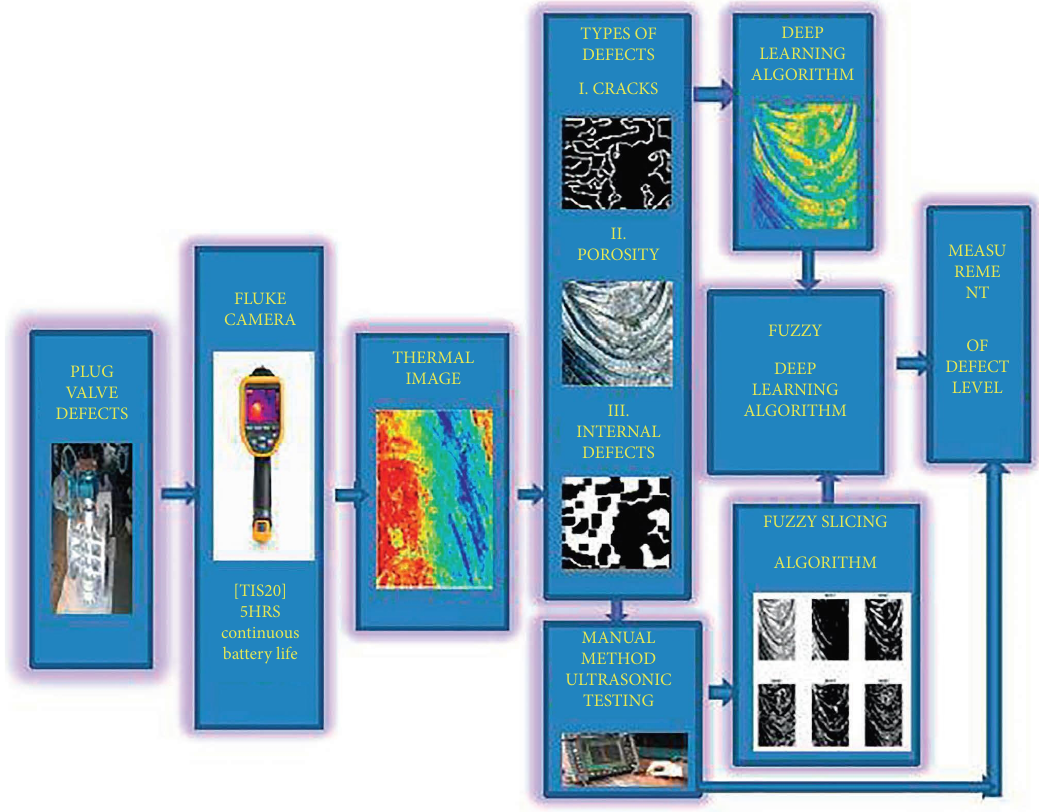
Figure 2: Block diagram of the proposed